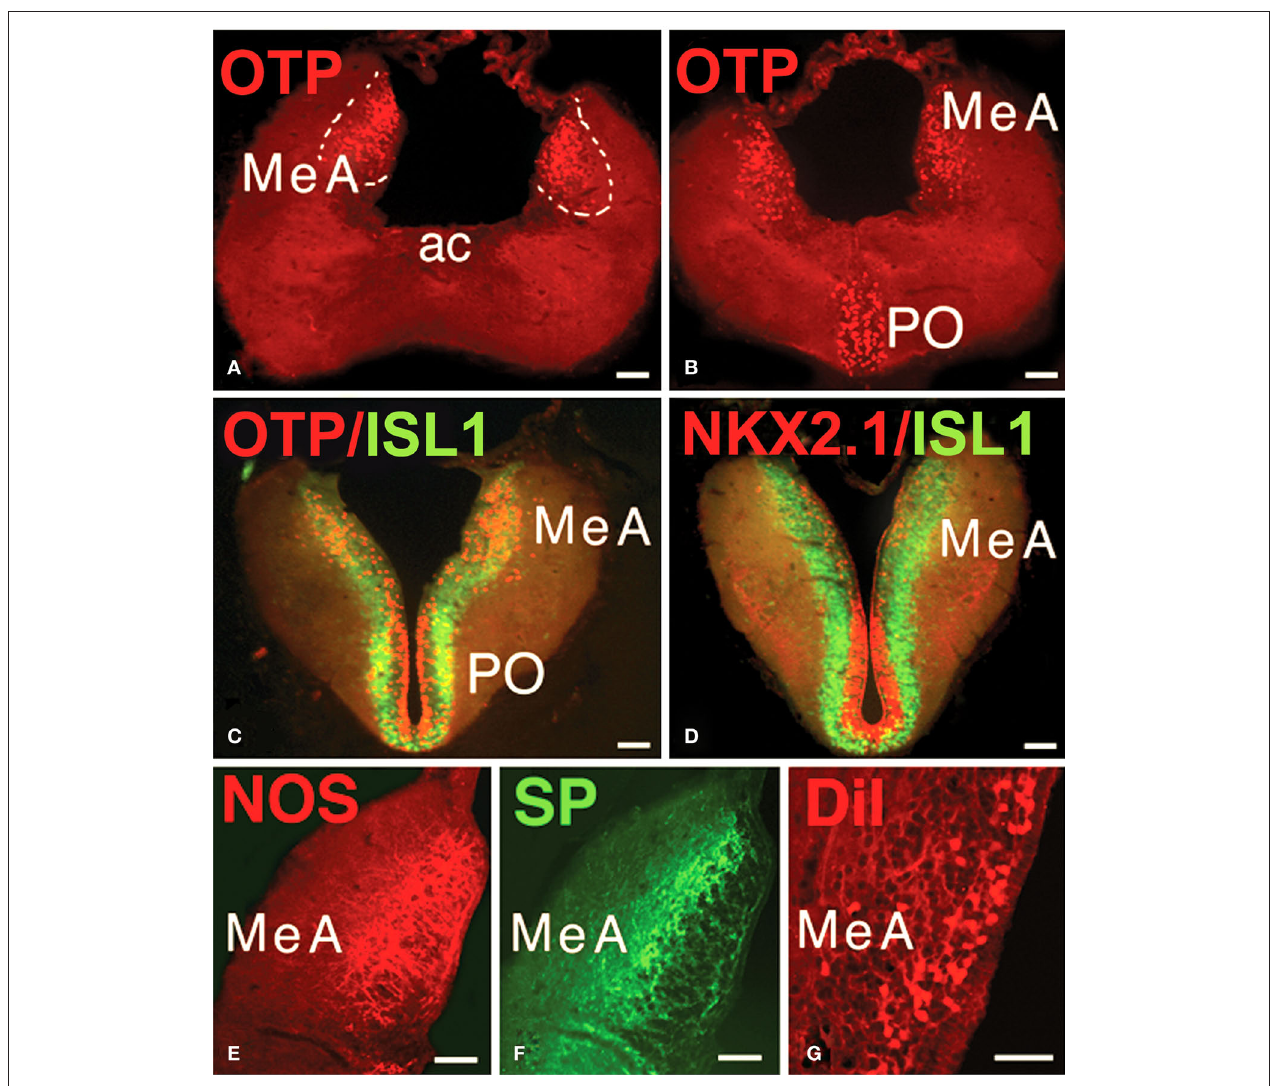
Figure 6 | Characterization of the MeA. (A,B) The MeA can be identified by its specific OTP-immunoreactivity. (C,D) The presence of ISL1-immunoreactivity and the virtual lack of NKX2.1 labeling characterize the MeA. (e,F) The distinct distribution of NOS and SP immunoreactive structures identifies the